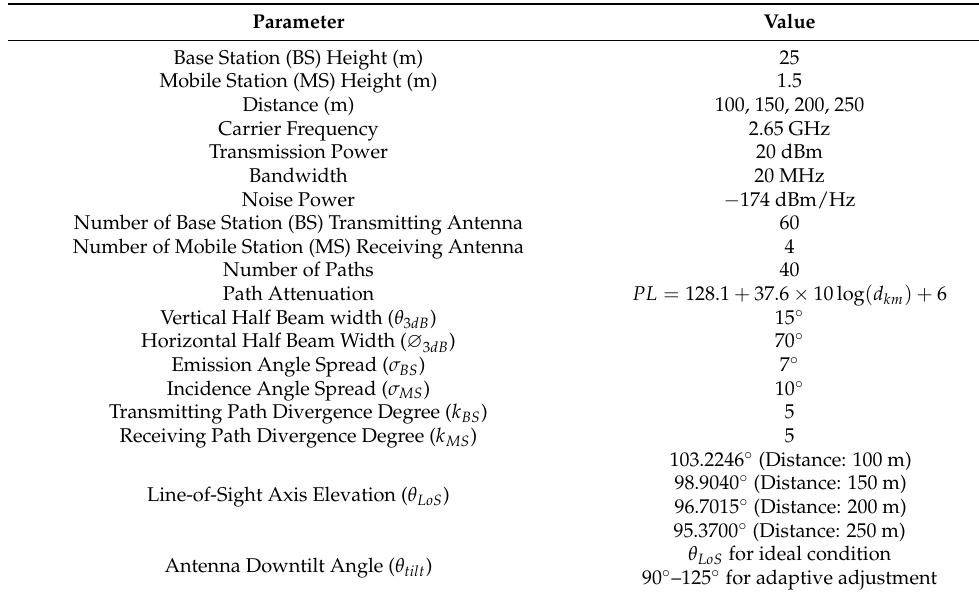
Table 3. Simulation parameters for 60 ×